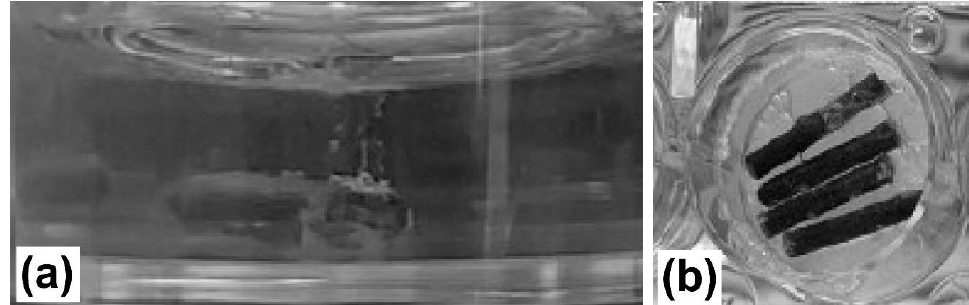
Figure 11. Visualization of extracts during materials incubation in culture medium: hydrogen generation ( a ), dark colour of wires surface after 72-h preincubation in culture media and change of media colour ( b ).